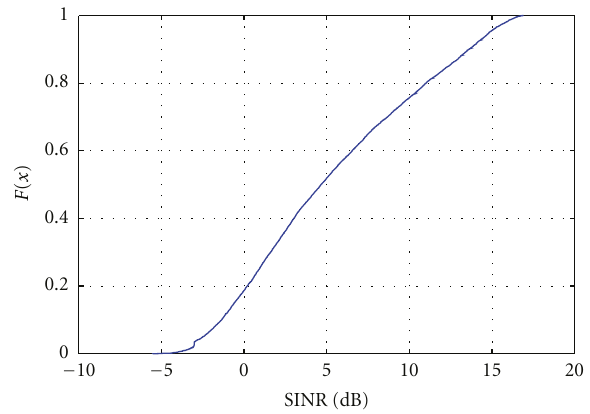
Figure 6: CDF of SINR experienced by a